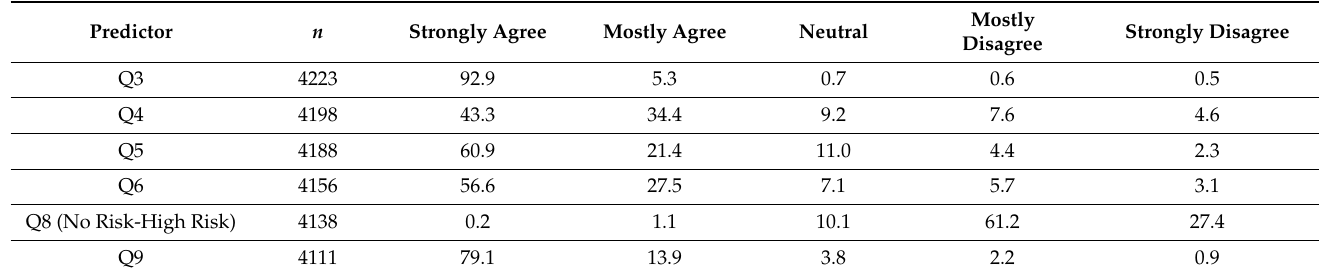
Table 3. Summary of responses to Likert-type scale items (Questions 3–6, 8, 9).